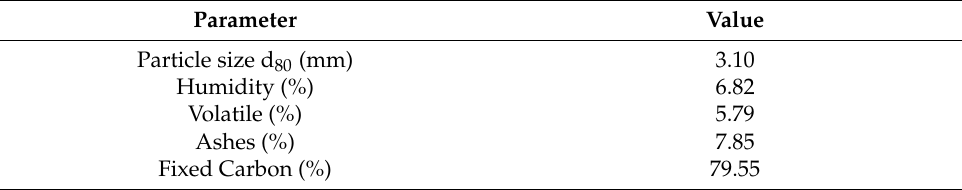
Table 2. Physical and chemical properties of AC.